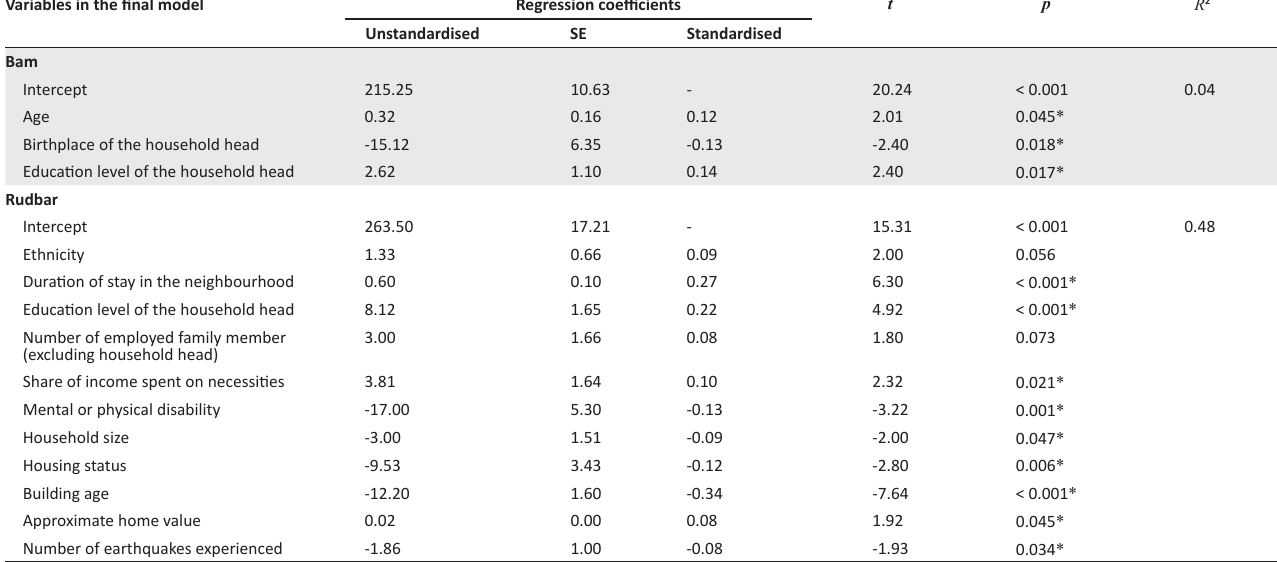
TABLE 6: Assessing the effects of demographic, social and economic variables on total resilience of Bam and Rudbar cities. Variables in the final